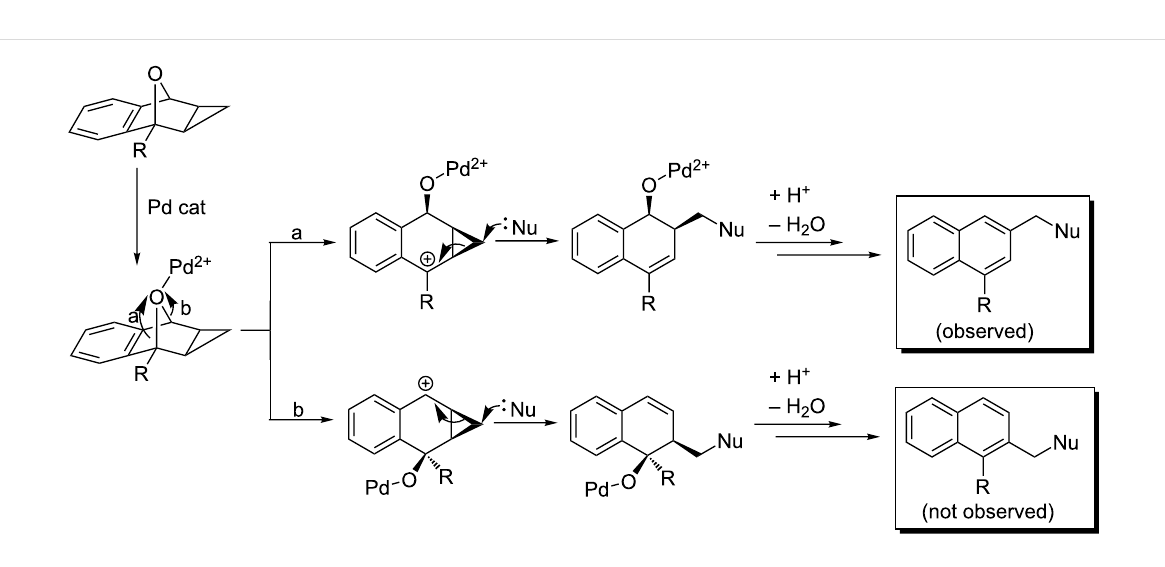
Scheme 4: Formation of the possible regioisomers for the ring opening of asymmetric C1-substituted cyclopropanated